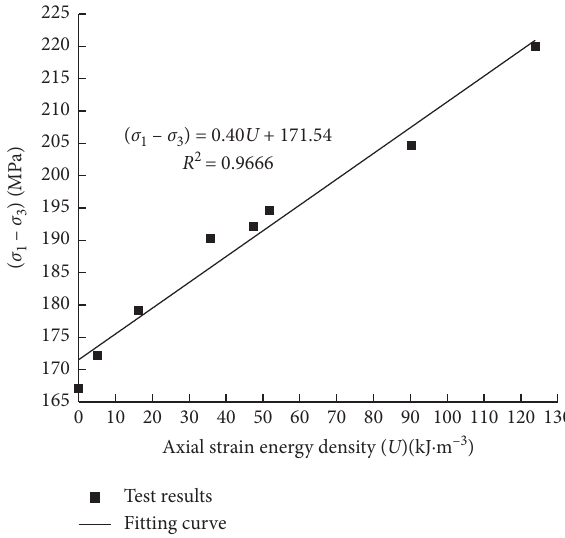
Figure 14: Relationship between axial strain energy density and peak strength.